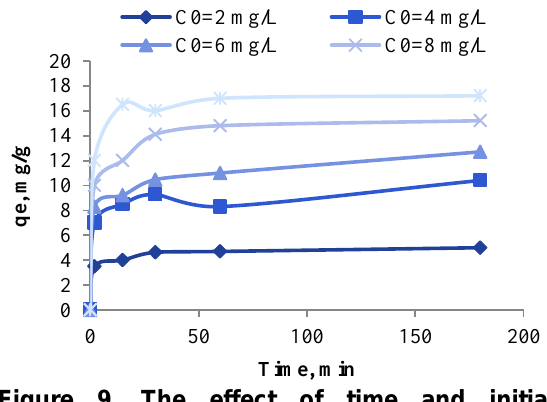
Figure 9. The effect of time and initial concentration on adsorption of copper on MCh/Fe-Zr nanoparticles in temperature 25 o C, adsorption dose of 0.4 g/l, speed of 300 rmp, time of 300 minutes, and pH of 9